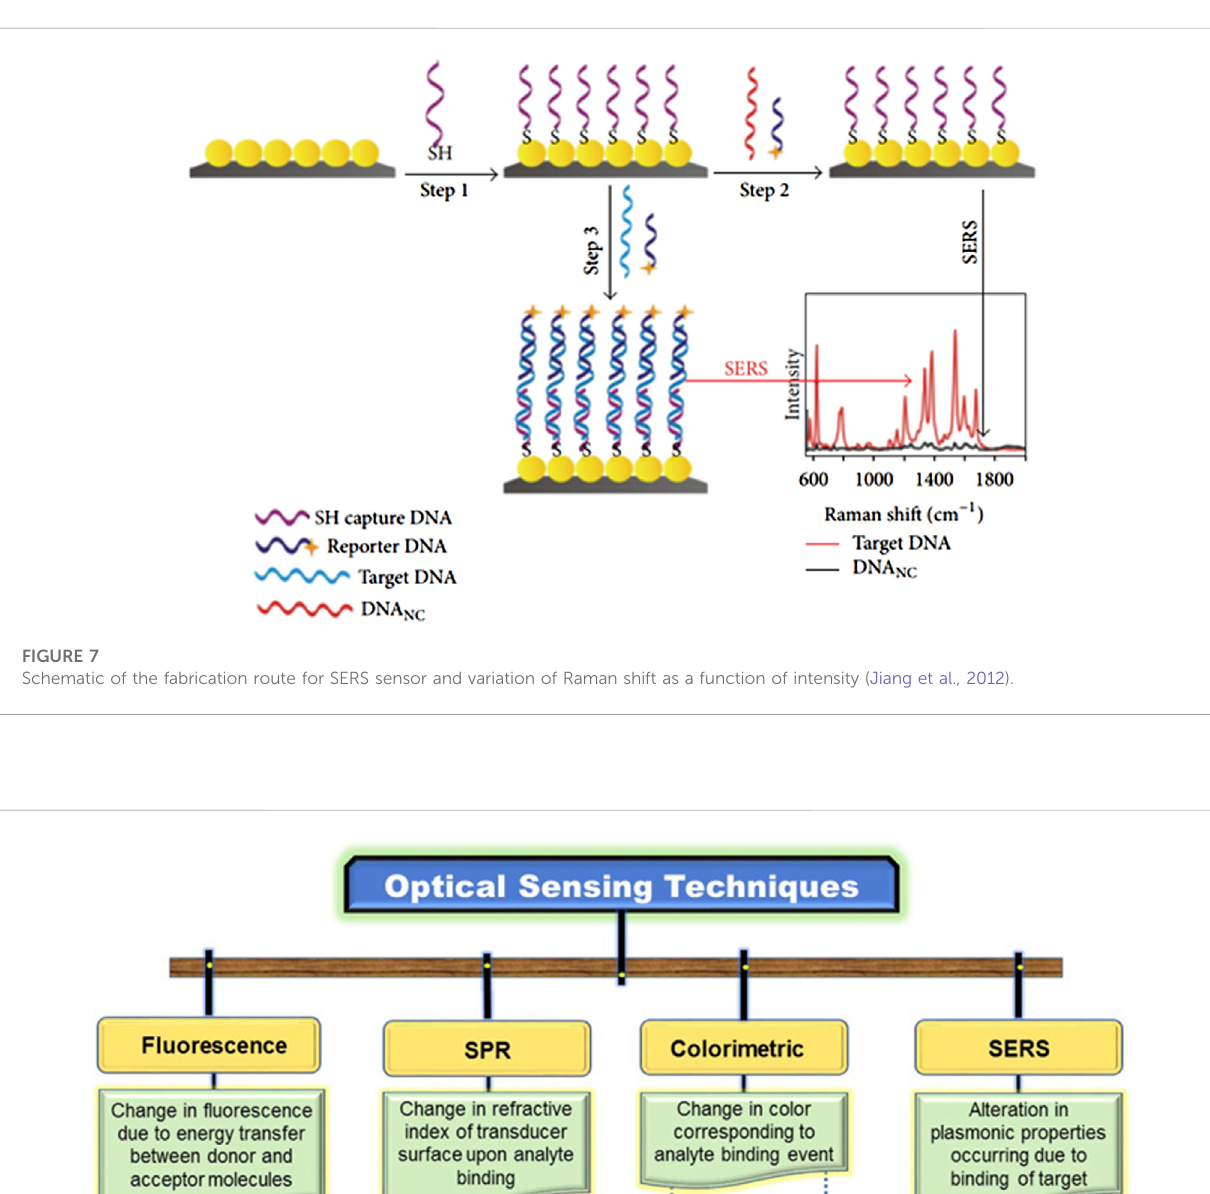
Division of optical sensors (Vikrant et al.,